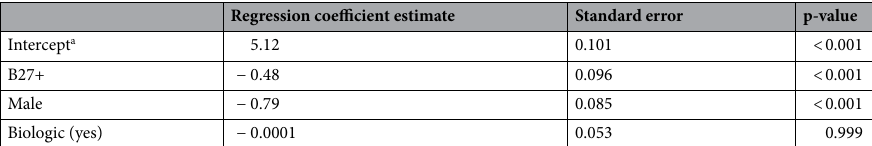
Table 2. Linear regression analysis of the impact of sex, HLA-B27 positivity, or use of a Biologic on the BASDAI score. a The intercept is the average BASDAI score for a female who is HLA-B27 negative and not taking a biologic. The regression coefficient shows how much lower the BASDAI would be on average if the respondent is HLA-B27 positive or male or taking a